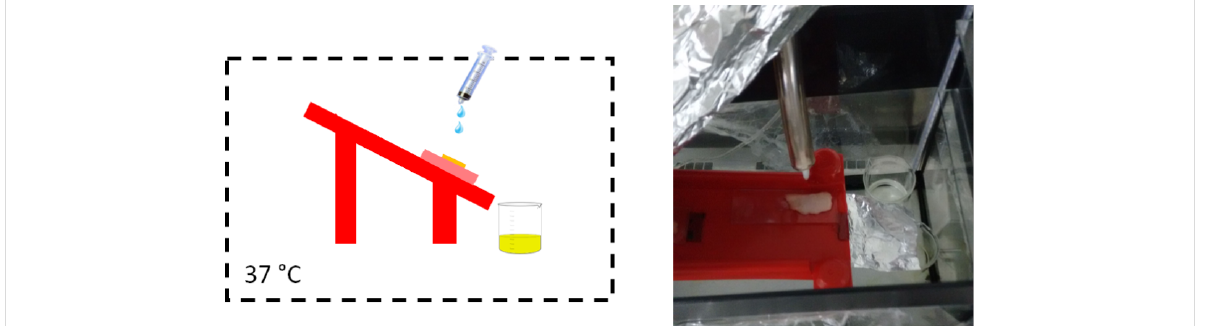
Figure 14: Schematic presentation of the setup utilized for ex vivo liquid falling mucoadhesion tests.